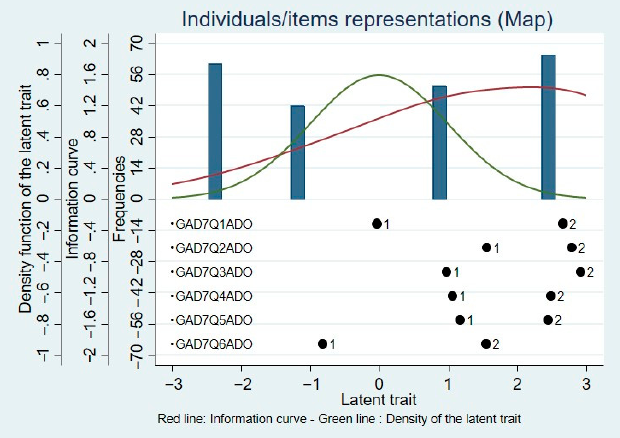
Figure 2. Map of individuals/items representations: latent trait (anxiety) in function of density of the latent trait, information curve, and frequencies, with indicated thresholds of response modes for each item (GAD-6).